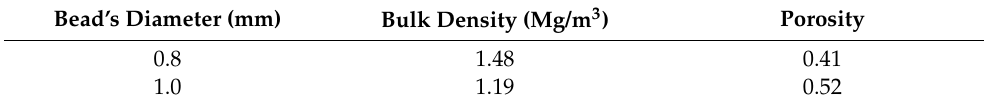
Figure 2. Two layers of the glass beads’ porous media were packed into the 2.4 mm thickness Hele- Shaw cells. The boundary of the 0.8 mm and 1.0 mm beads’ layers was the widening of the capillary model. The green LED indicated the status of the solenoid valve. Table 1. Average bulk density and porosity of 0.8 mm and 1.0 mm beads